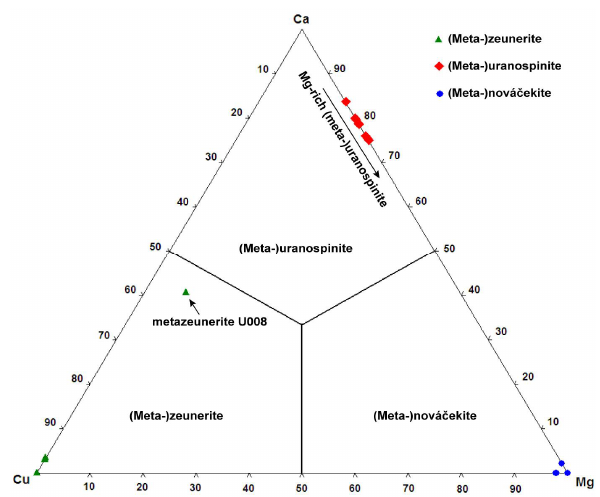
Figure 4. Ternary plot of the A -site occupancy of the members for the (meta-)autunite group from